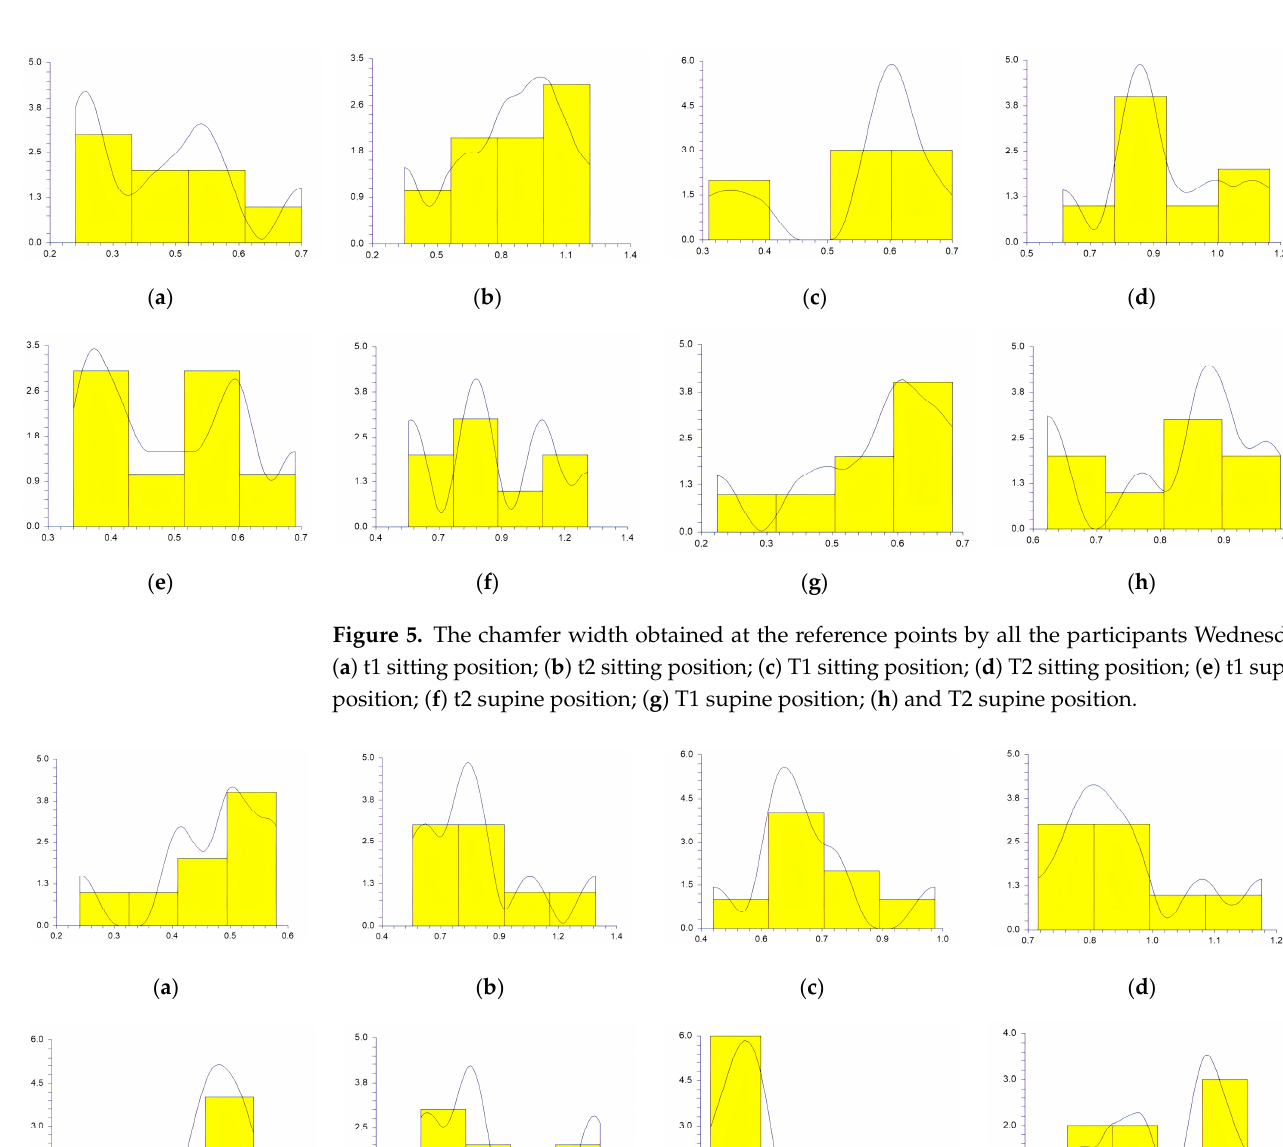
Figure 4. The chamfer width obtained at the reference points by all the participants Tuesday: ( a ) t1 sitting position; ( b ) t2 sitting position; ( c ) T1 sitting position; ( d ) T2 sitting position; ( e ) t1 supine